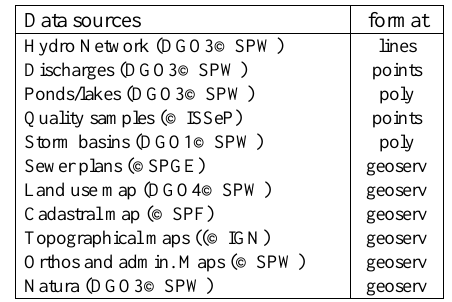
Table 3. Types of geodata integrated in the